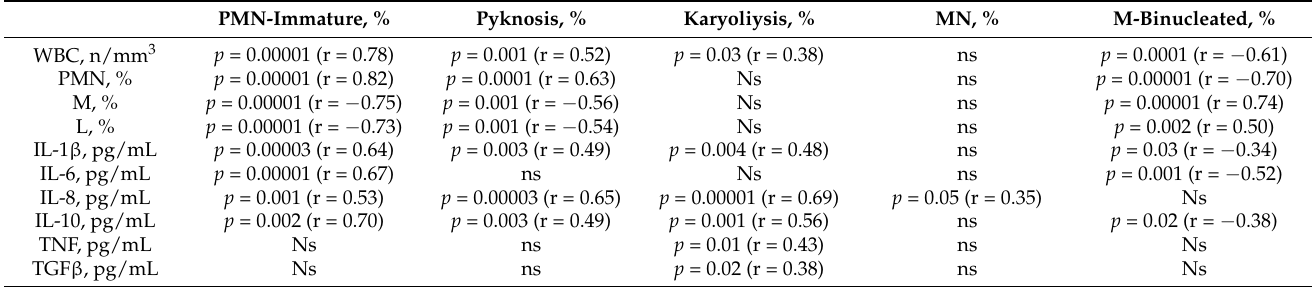
Table 5. Correlations between the SF cytokine, chemokine, and growth factor levels and immature PMN, frequency of pyknosis, karyolysis, MN, and binucleated